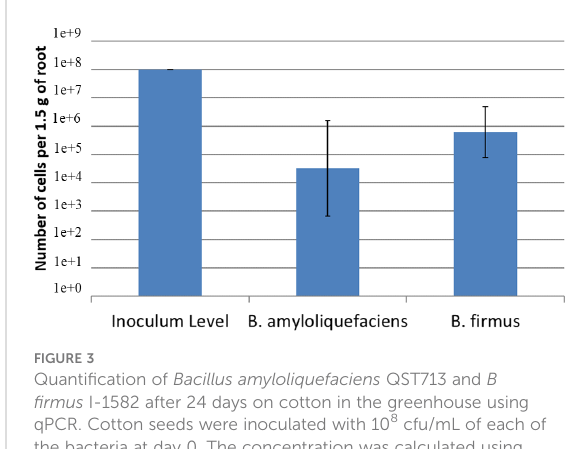
FIGURE 3 Quanti fi cation of Bacillus amyloliquefaciens QST713 and B fi rmus I-1582 after 24 days on cotton in the greenhouse using qPCR. Cotton seeds were inoculated with 10 8 cfu/mL of each of the bacteria at day 0. The concentration was calculated using the standard curves for each bacteria; B amyloliquefaciens QST713: y = -1.9421x + 34.227; R 2 = 09371; B fi rmus QST713 I- 1582: y = -2.2036x + 44.362; R 2 = 08217. The treatments were done in a replicate of 5 per assay and the assay was repeated 3 times. Data were statistically analyzed in SAS 9.4 using the Glimmix procedure with P ≤ 0.1. The treatments did not signi fi cantly differ from each